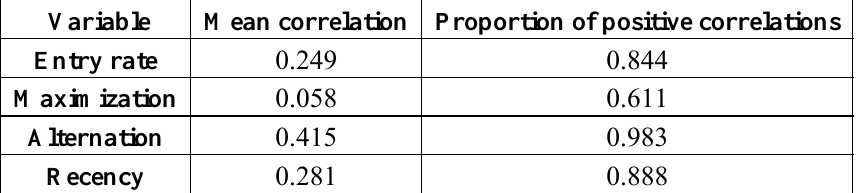
Table 3. Summary of correlation analyses that examine the possibility of consistent individual differences. The summary scores are based on 180 correlation analyses (180 pairs of games) for each of the four